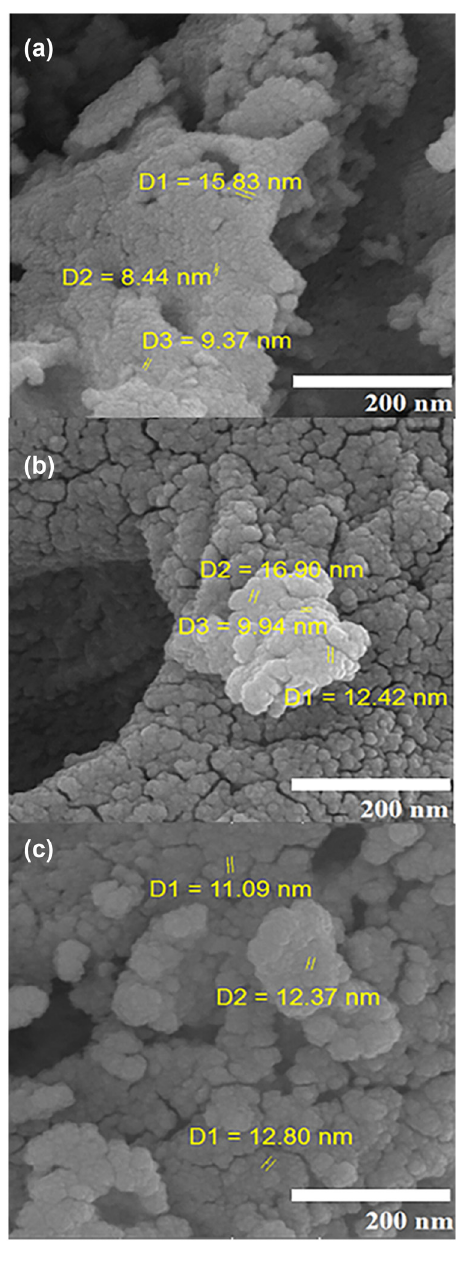
Figure 4: SEM images of the fabricated ZnO NPs by the red pepper extract and conventional heating ( a ) , autoclave ( b ) , and microwave irradiation ( c )